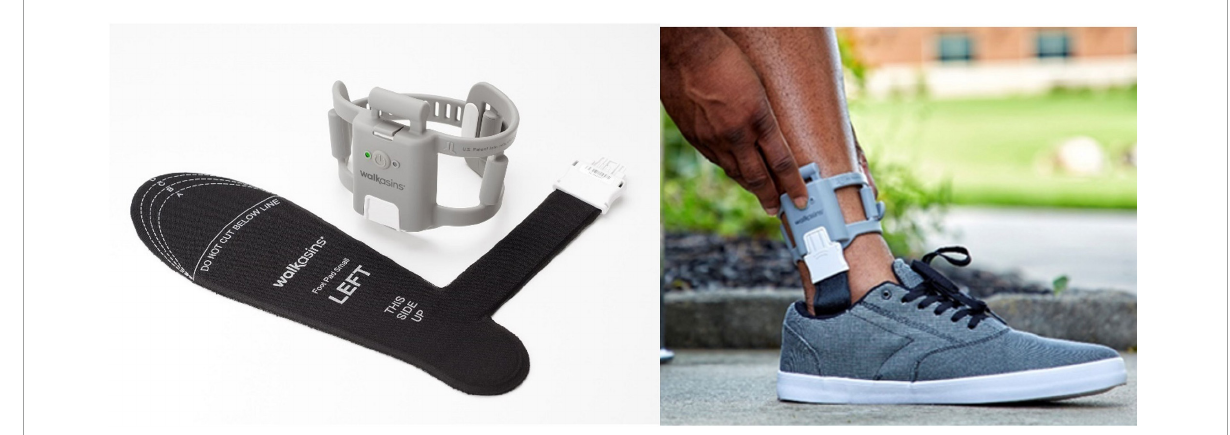
FIGURE1 (Left) The two components of the Walkasins prosthetic device, the pressure sensitive flexible foot pad that is placed in the shoe and connects to the leg unit that contains a rechargeable battery, a microprocessor, supporting electronics, and four mechanical tactile stimulators. The embedded software algorithm evaluates pressure data and activates the mechanical tactile stimulators at relevant times during standing and walking to signal balance-related information to the afferent nervous system. (Right) A Walkasins user wearing the device in the process of turning it on. The Walkasins system is worn bilaterally (unilateral components